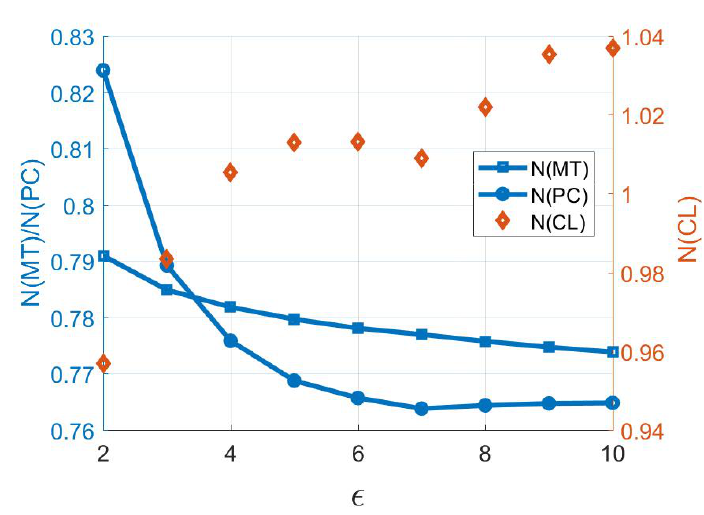
Figure 9. N(MT), N(PC), and N(CL) versus (cid:101) .